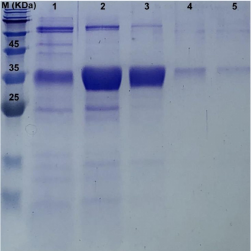
Figure 3. Analysis of the recombinant PaPP5c by 15% SDS-PAGE. M: protein marker; Lane 1: 50 mM imidazole elution; Lane 2: 100 mM imidazole elution; Lane 3: 150 mM imidazole elution; Lane 4: 200 mM imidazole elution; Lane 5: 250 mM imidazole elution.